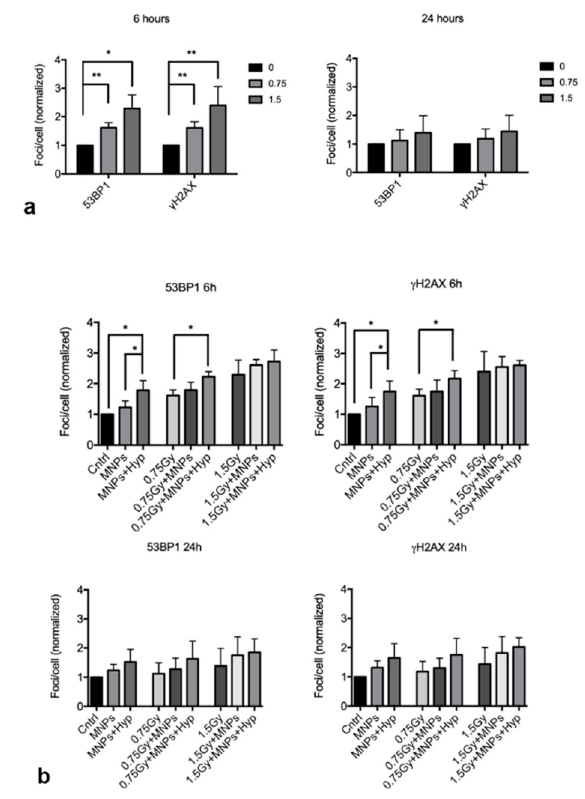
Figure 6. Analysis of 53BP1 and γ H2AX foci induction after 6 and 24 h from the exposure to 0.75 and 1.5 Gy of carbon ions alone ( a ) and in combination with MNP uptake and / or Hyp in BxPC3 pancreatic tumor cells ( b ). * indicates p < 0.05, ** indicates p < 0.01 (one-way ANOVA and Tukey’s multiple comparison post-test).